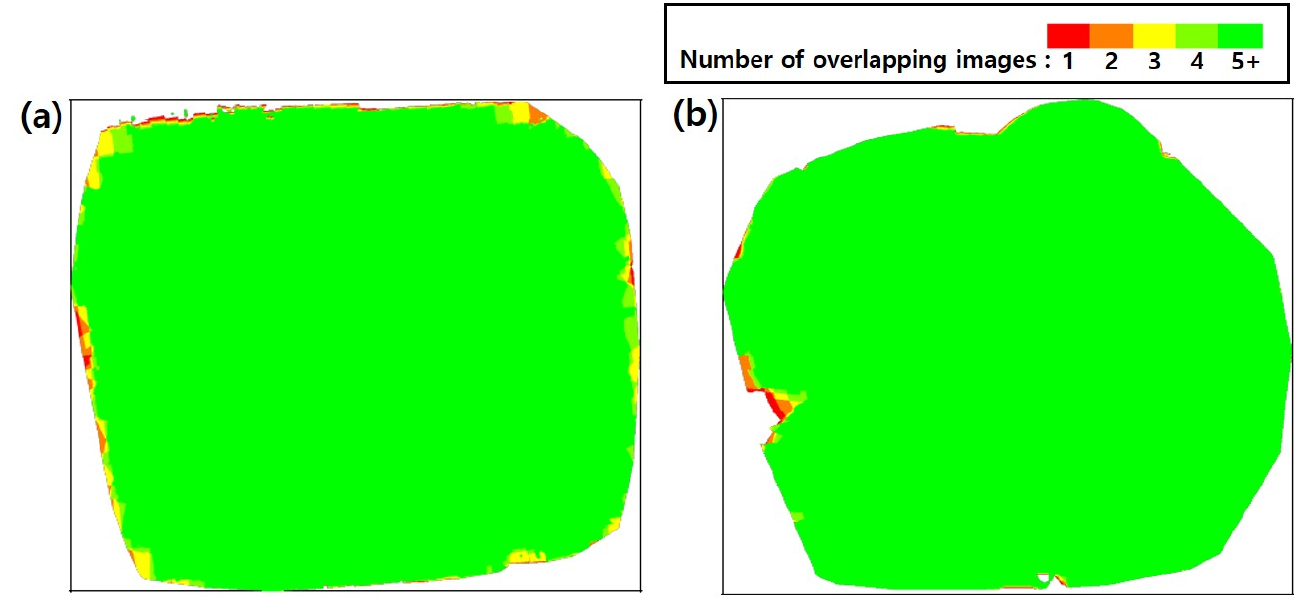
Figure 2. The number of overlapping images in the thermal mosaic of the experimental site with the point cloud. The green areas indicate a degree of overlap by more than five images. The red and yellow areas indicate a low overlap, resulting in poor mosaic quality. ( a ) Photo-mosaic; ( b ) Video-mosaic.